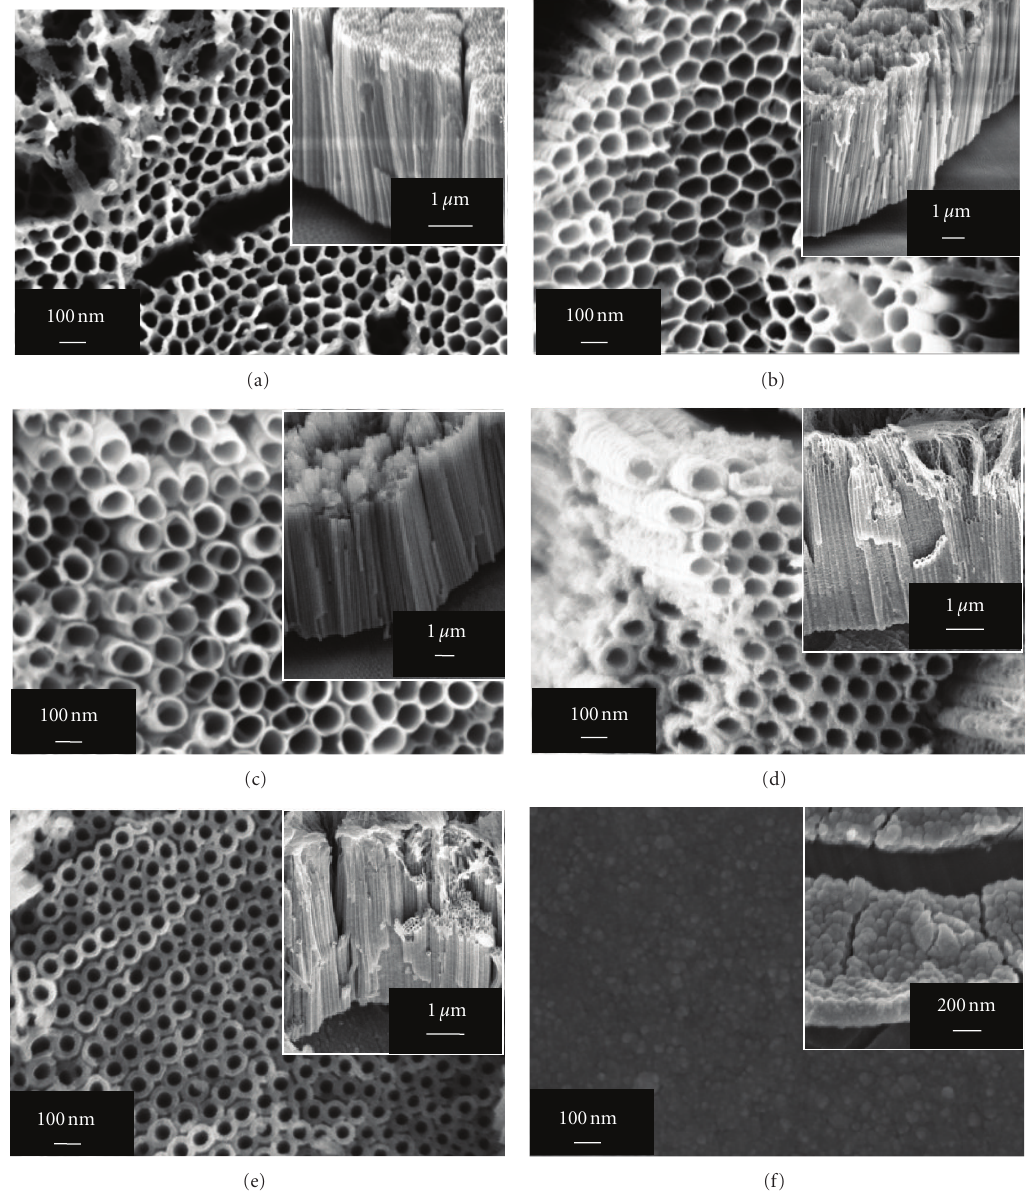
Figure 1: FESEM images of TiO 2 nanotube arrays fabricated at (a) 10 ◦ C, (b) 20 ◦ C, (c) room temperature, (d) 40 ◦ C, (e) 60 ◦ C, and (f) 80 ◦ C in ethylene glycol electrolyte containing 5wt% H 2 O 2 and 5 wt% NH 4 F anodized at 60V for 1 h. Insets are the cross-section morphologies of the TiO 2 nanotube